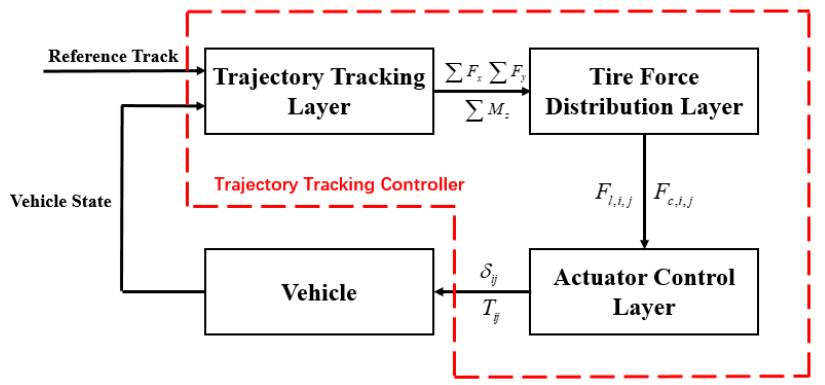
Figure 1. Trajectory tracking controller architecture.